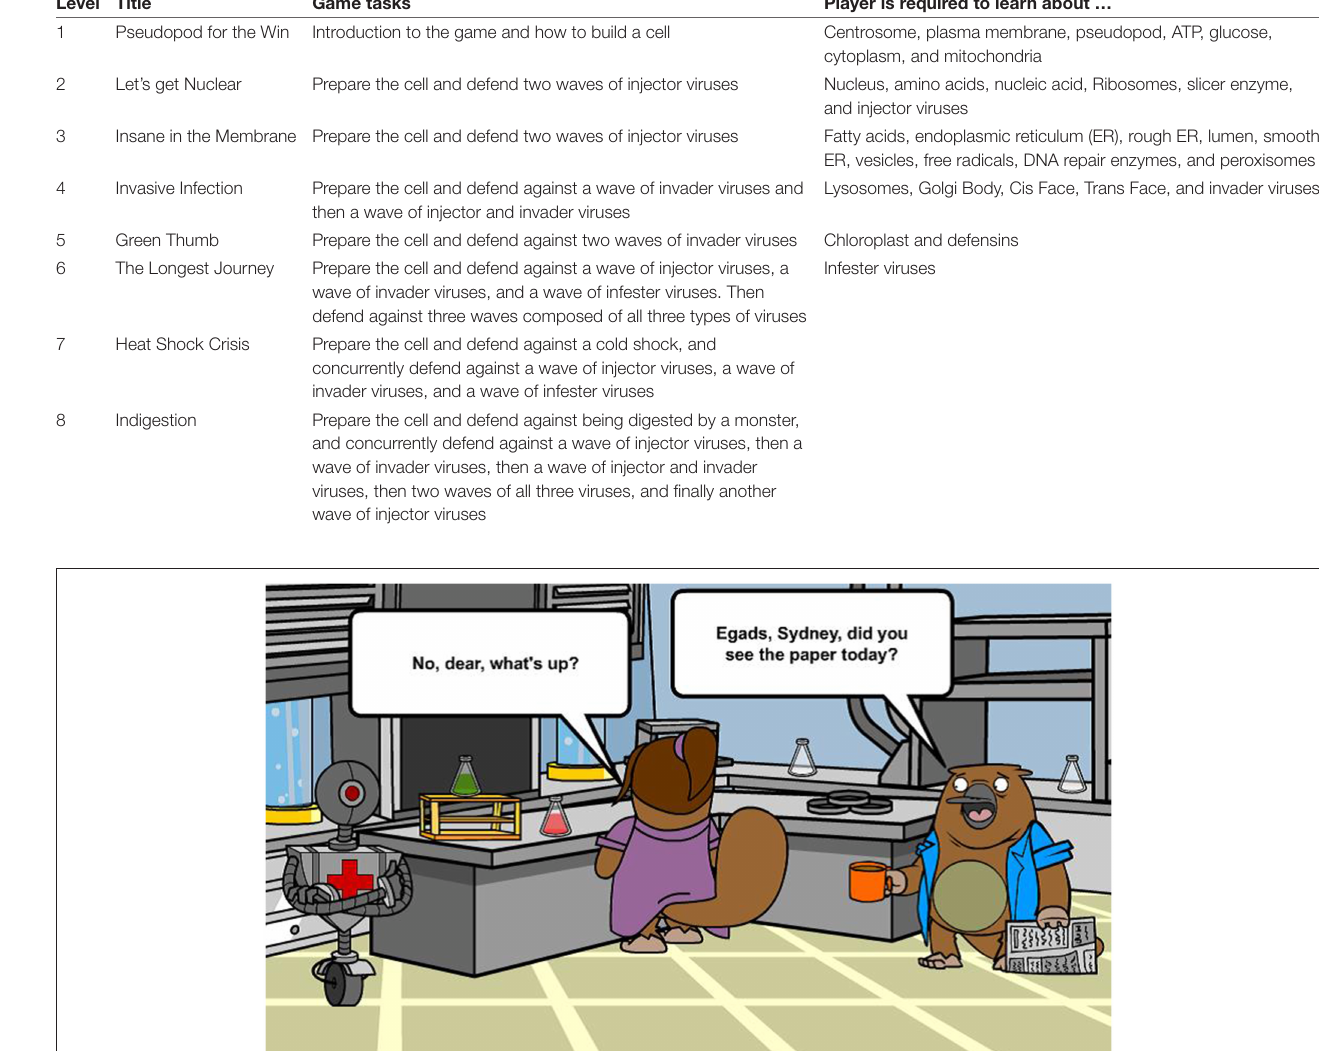
TABLE 2 | Overview of the game tasks and presented concepts per level of the CellCraft game. Level Title Game